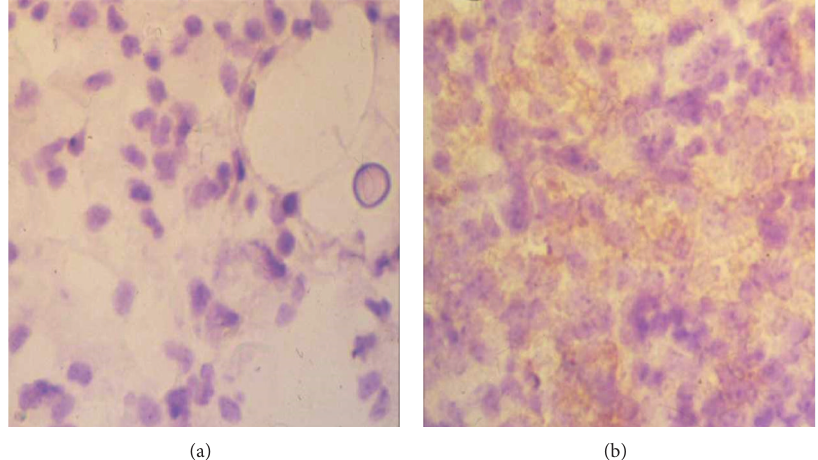
Figure 2: (a) Macrophages in the lung of mice infected C. neoformans TIMM 0362 showed no expression of MHC class II IAd molecule (immunohistochemistry, original magnification × 400). (b) Macrophages in the lung of mice infected with C. neoformans TIMM 0372